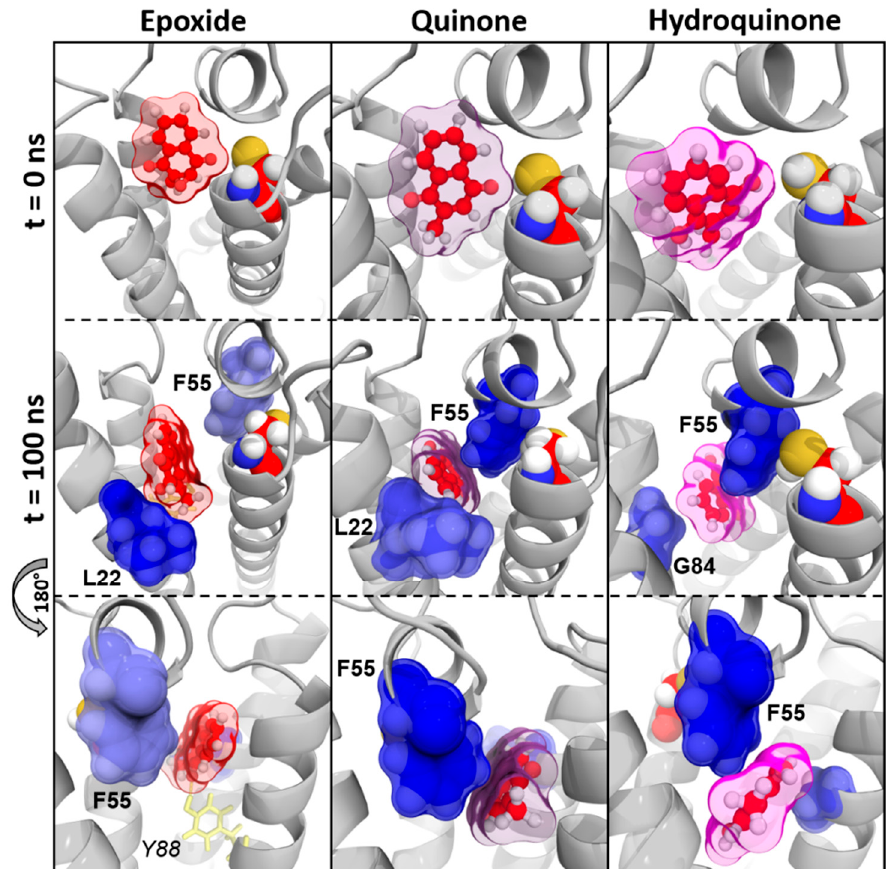
Figure 6. Vitamin K3 interactions with vitamin K epoxide reductase (VKORC1) in molecular dynamics (MD) simulations. Vitamin K3 is shown as red sticks and spheres; the transparent surface is colored as red, violet, and pink for epoxide, quinone, and hydroquinone states of vitamin K3, respectively. The VKORC1 protein structure is depicted as a grey image; the C135 residue is presented as red spheres. Oxygen, nitrogen, sulfur, and hydrogen atoms are colored in red, blue, yellow, and white, respectively. VKORC1 residues involved in hydrogen bonds with vitamin K3 are shown as yellow sticks (hydrogen bonds are depicted as yellow dashes) and numbered in italic characters. VKORC1 residues contributing to vitamin K3–VKORC1 binding free energy are presented as blue spheres and a transparent surface (the darker the blue is, the stronger the interaction is) and numbered in bold characters.